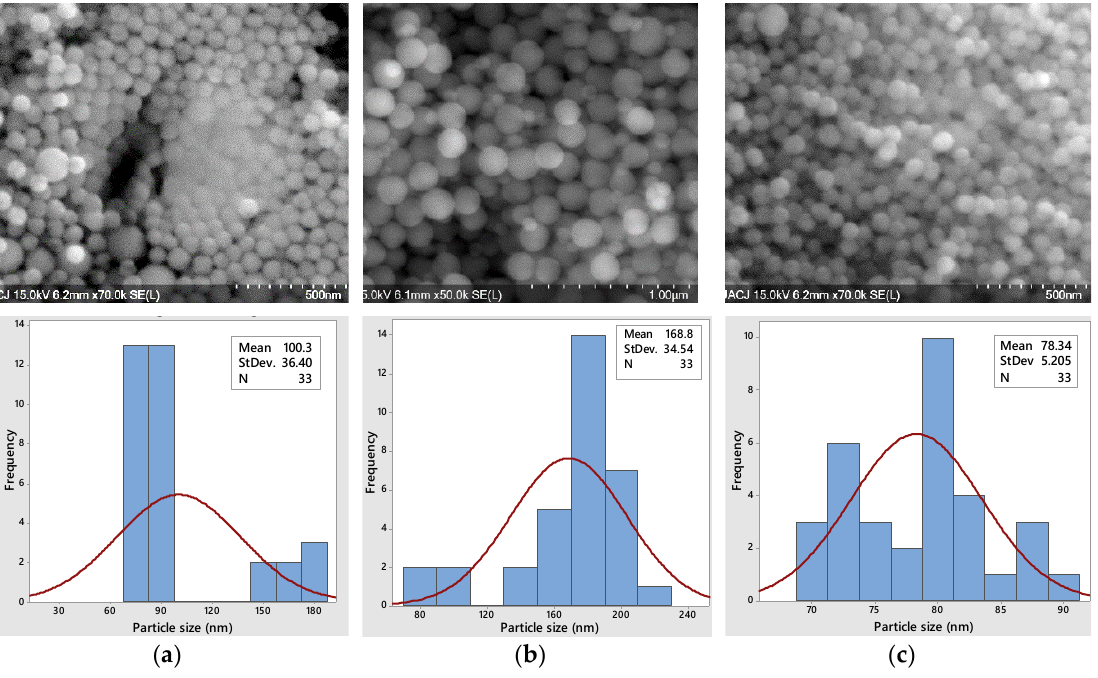
Table 3. Elemental analysis of the SiO 2 nanoparticles. Figure 8. SEM images and histograms of particle size distribution of SiO 2 NPs: ( a ) before centrifugation, ( b ) precipitated phase after centrifuge and ( c ) supernatant phase after centrifuge.